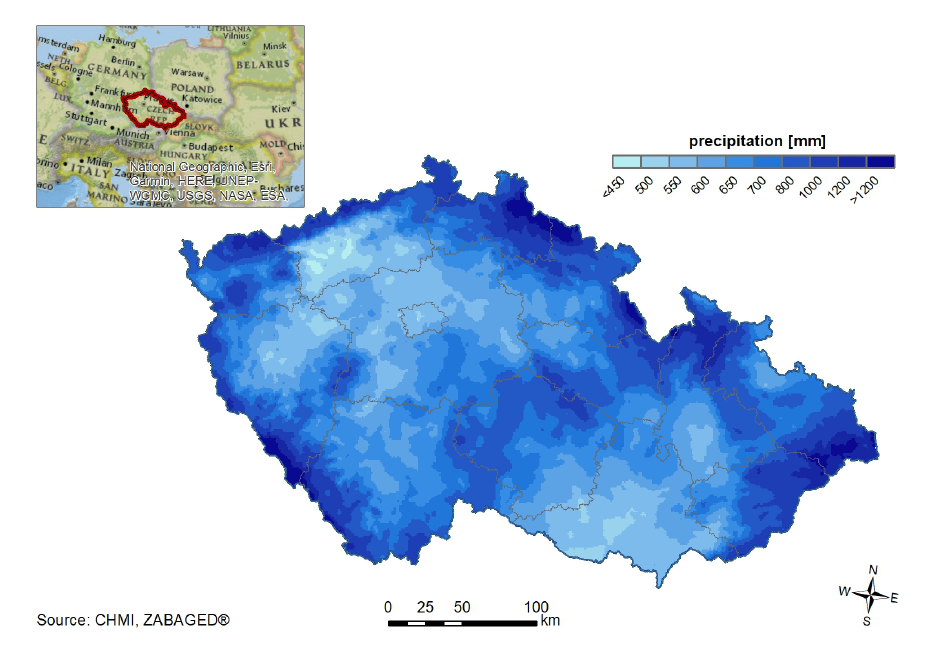
Figure 1. Spatial distribution of average annual precipitation in the Czech Republic for the reference period 1981–2010.